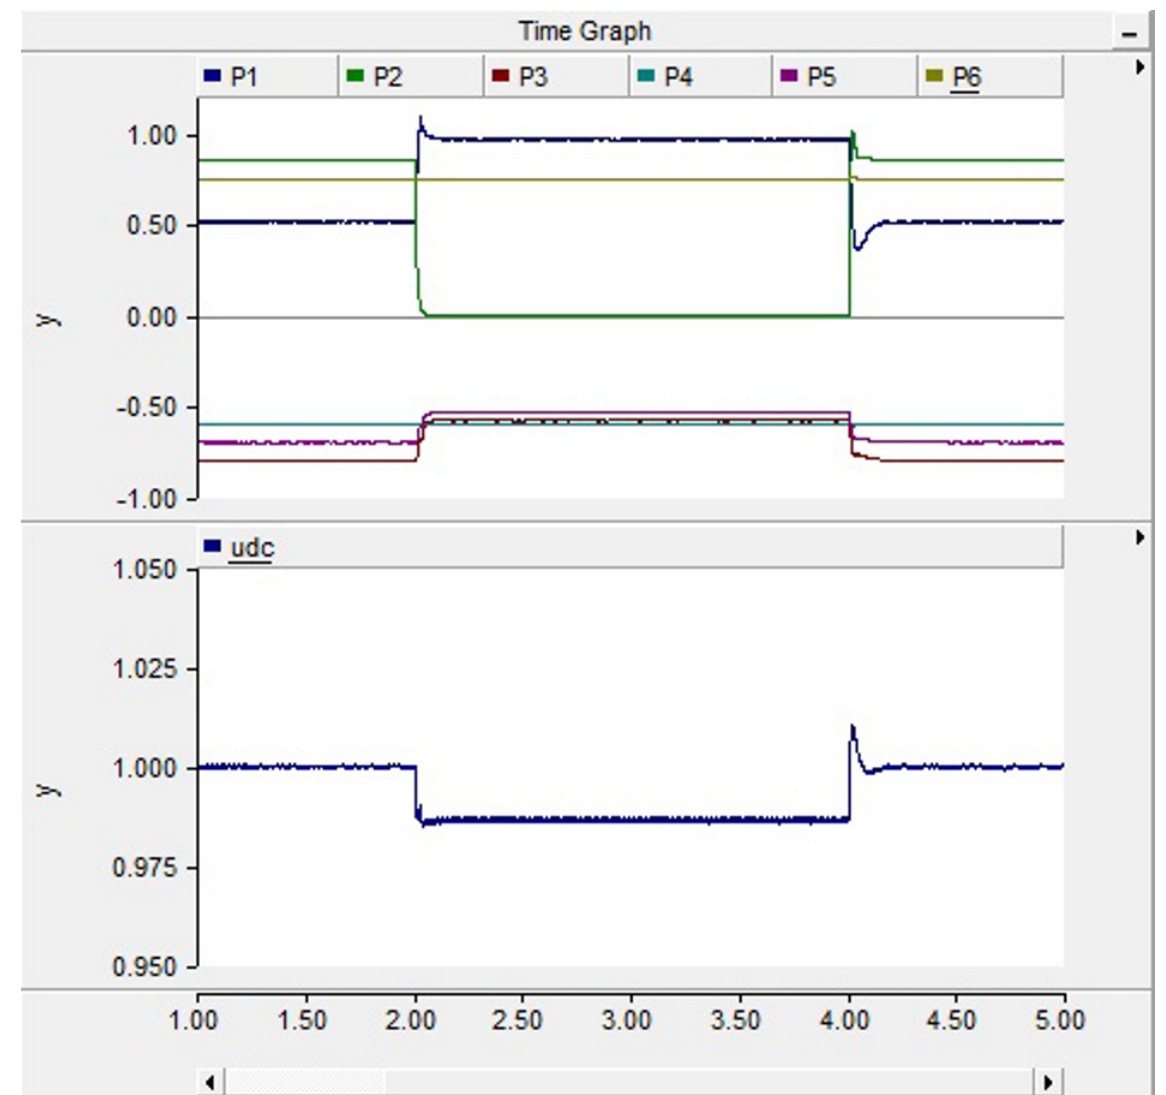
Figure 11. Responses at loss of VSC